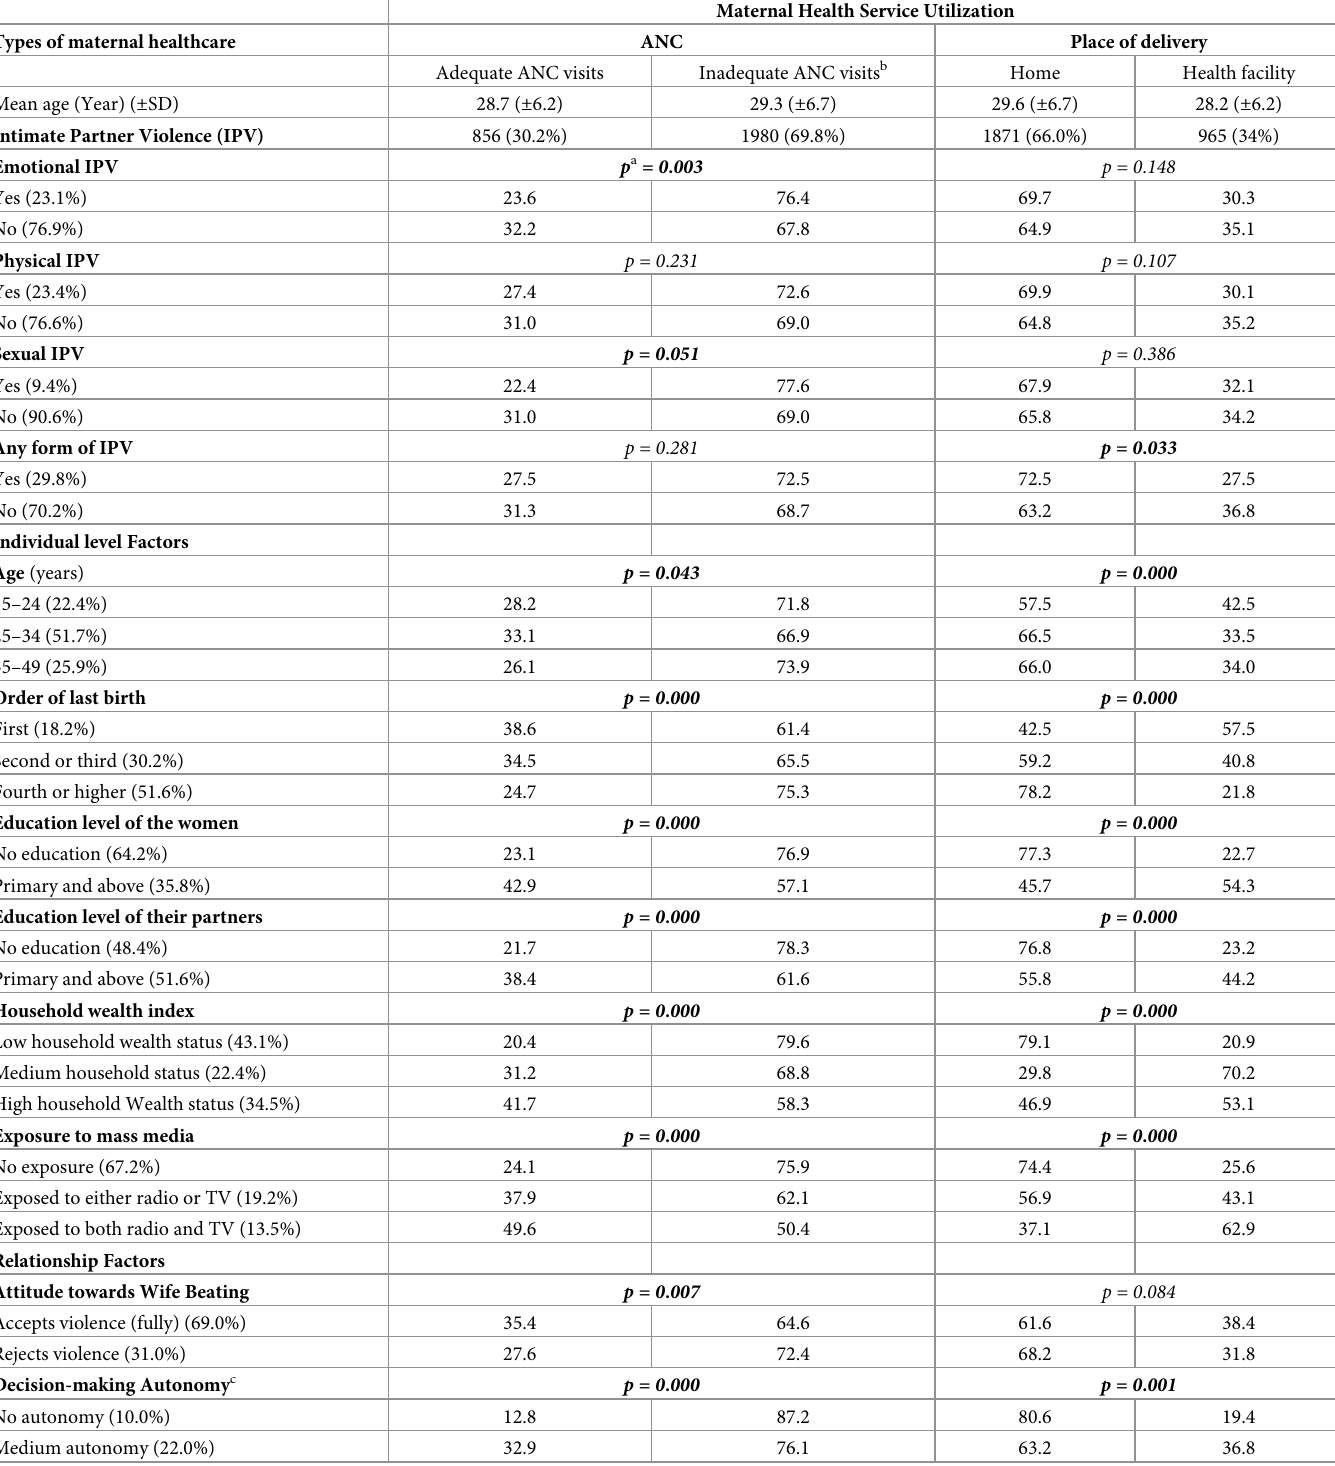
Table 1. Sociodemographic characteristics and exposure to IPV by utilization of maternal healthcare services among (2836) aa women in the 2016 Ethiopian Demo- graphic Health